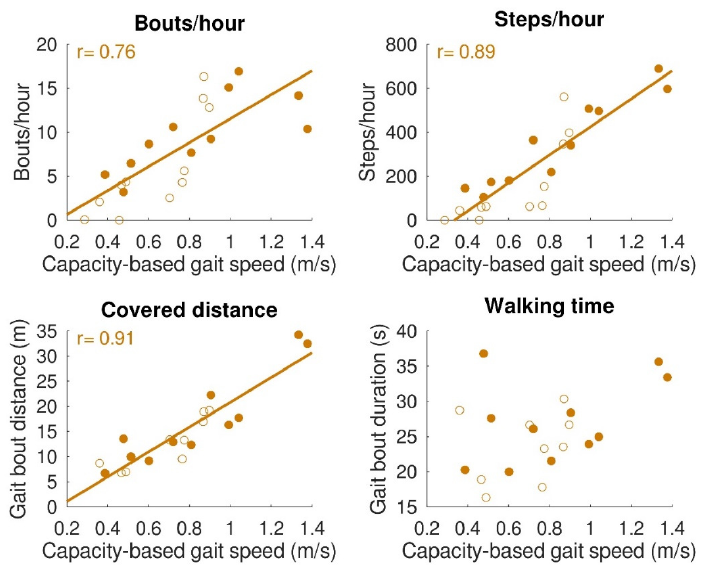
Figure 4. Relation between gait capacity and gait performance (walking activity). Bouts/hour (top left), steps/hour (top right), and distance covered (bottom left) were significantly correlated with capacity-based gait speed. Walking time (bottom right) was not significantly correlated with capacity-based gait speed. Filled dots indicate individual stroke patients, and open dots indicate individual patients with iSCI. In the case of a significant correlation, regression lines are depicted.